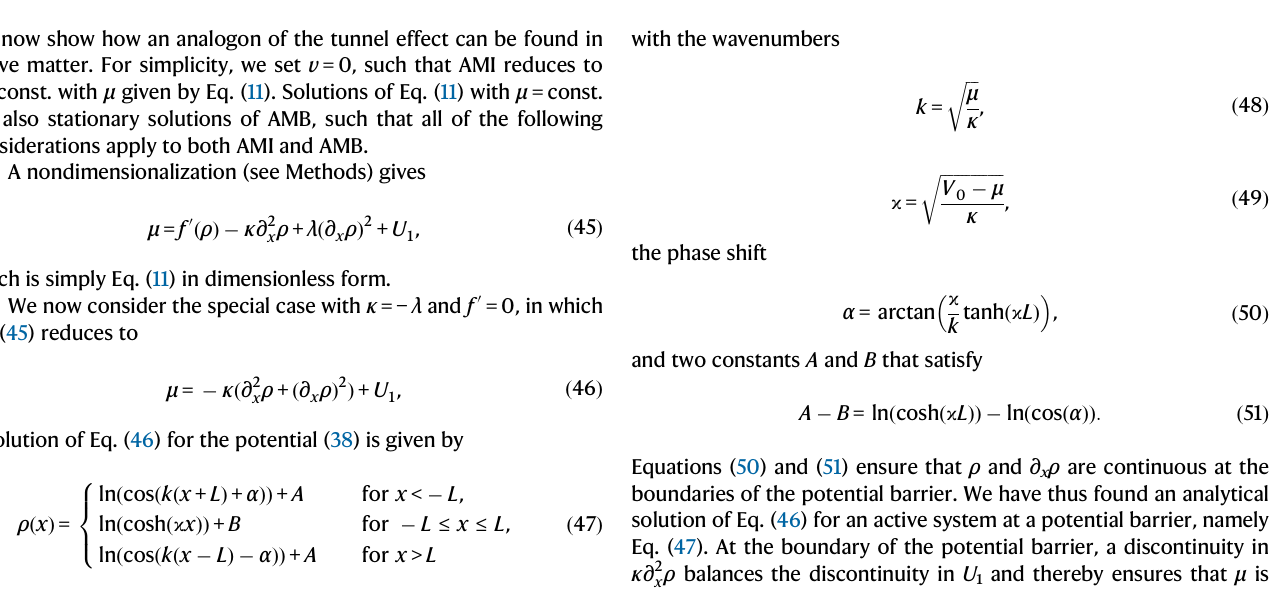
curve), which is used as the starting point for the continuation. d – f Like a – c , but with varying κ and fi xed a =0 and λ = − 1. g – i Like a – c , but with varying λ and fi xed a =0and κ =1.Notethatthegeneralformoftheanalyticalsolutionpersistsalsofor other parameter values, indicating that the tunnel effect in model (53) is a robust